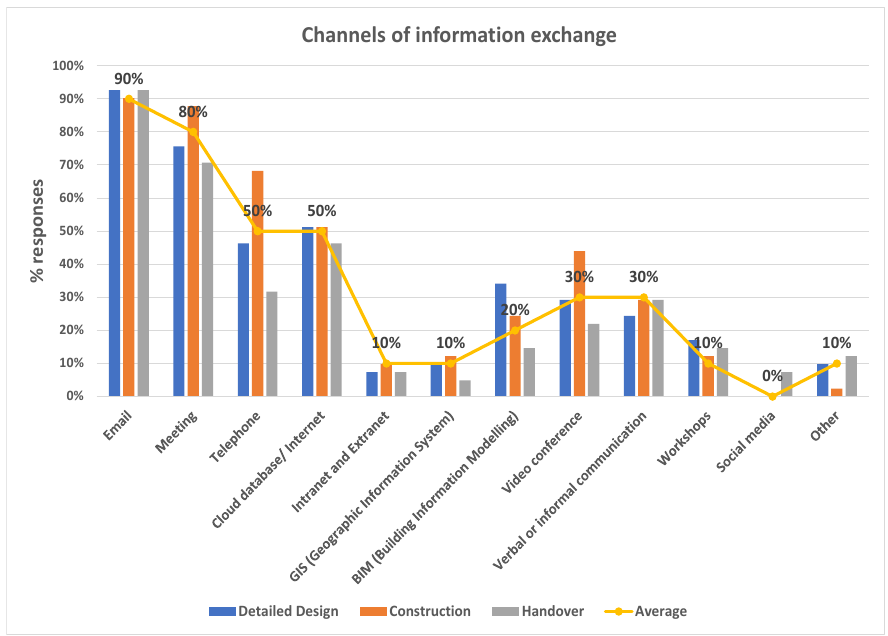
Figure 2. Channels of information exchange.